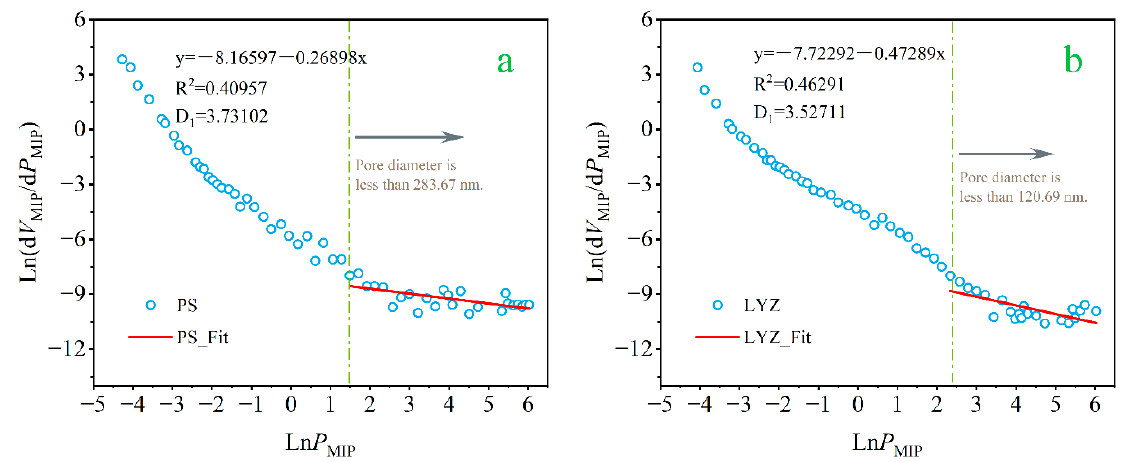
Figure 3. Fractal characteristics of mercury injection data of PS and LYZ coal samples.